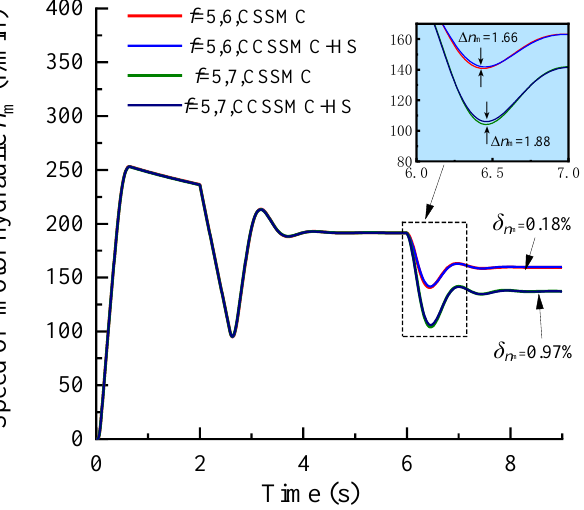
Figure 17. Variation curve of the hydraulic motor speed based on the CSSMC and CSSMC-HS.